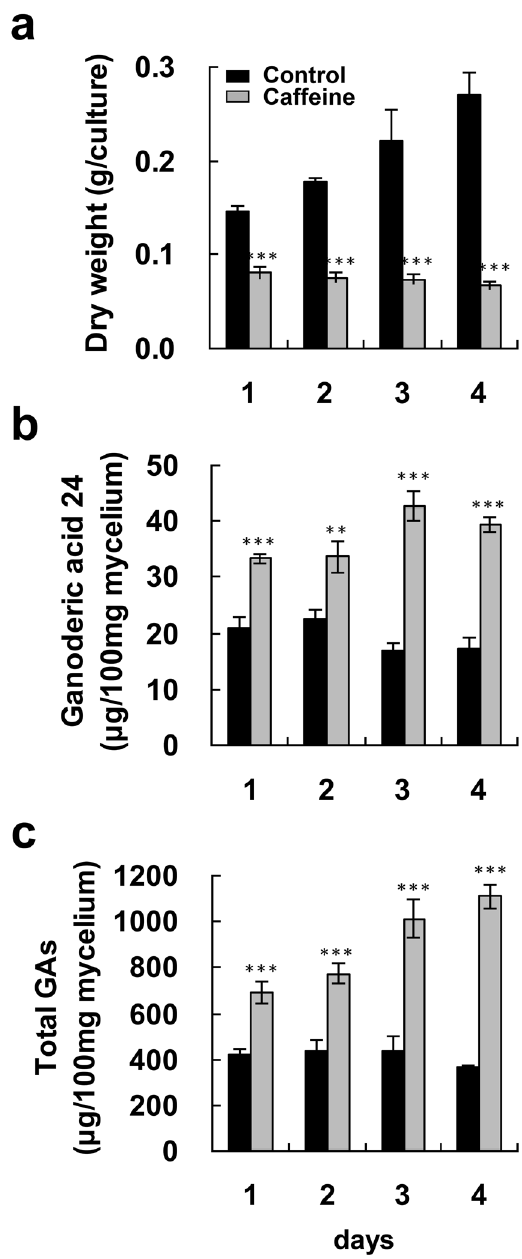
Figure 3. Time-course of fungal biomass and ganoderic acid production by Ganoderma lucidum after treatment with caffeine. Four-day-old fungal mycelium was cultured on potato dextrose agar (PDA) in 9-cm diameter petri dishes and then incubated with 80 mM caffeine in 25 ml potato dextrose broth (PDB) for 1–4 days. Dried mycelium was used to measure fungal biomass ( a ). Both lanosta-7,9(11), 24-trien-3 α -o1-26-oic acid (ganoderic acid 24) ( b ), and total ganoderic acids (GAs) ( c ) were measured by HPLC. The means of three independent samples with standard deviations are presented. * p < 0.05, ** p < 0.01, *** p < 0.001 as compared with the control